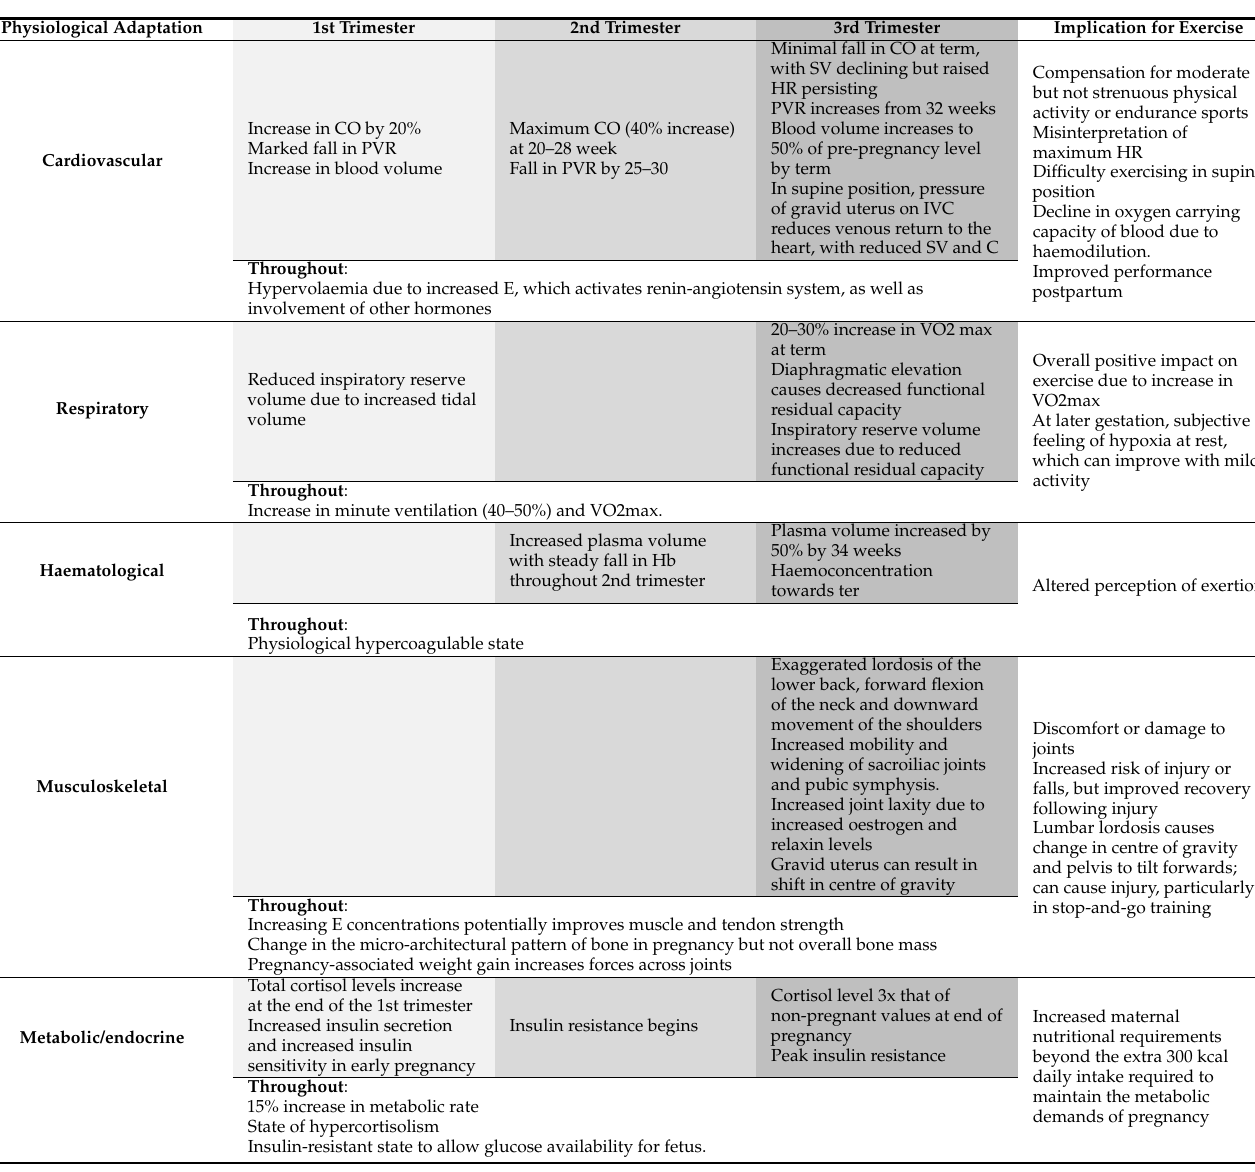
Table 1. Physiological changes in pregnancy and implications for exercise [11,14,15,19–27]. CO; cardiac output, E; oestrogen, Hb; haemoglobin, HR; heart rate, IVC; inferior vena cava, PVR;